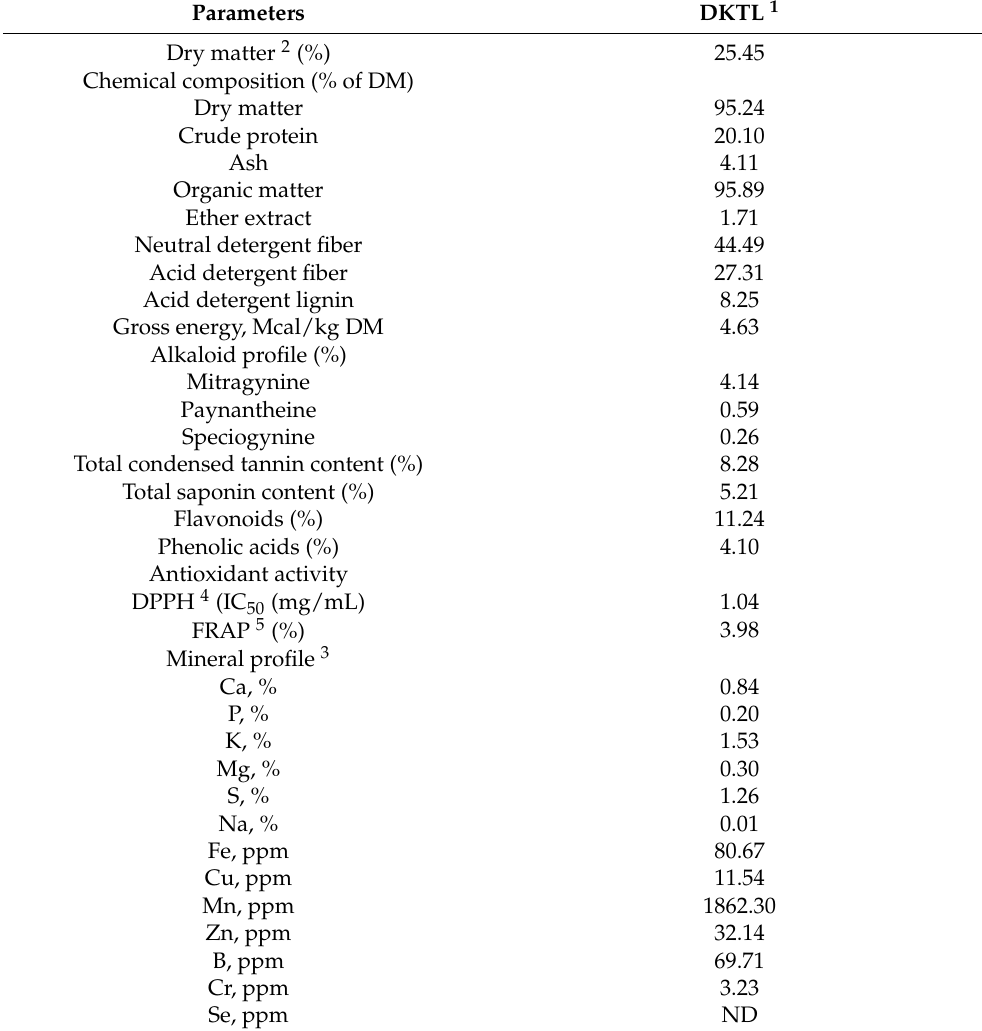
Table 2. Chemical composition and nutritive values of dried kratom leaves (DKTL) used in the experimental diets (on a dry matter basis) for goats ( n = 4/feed